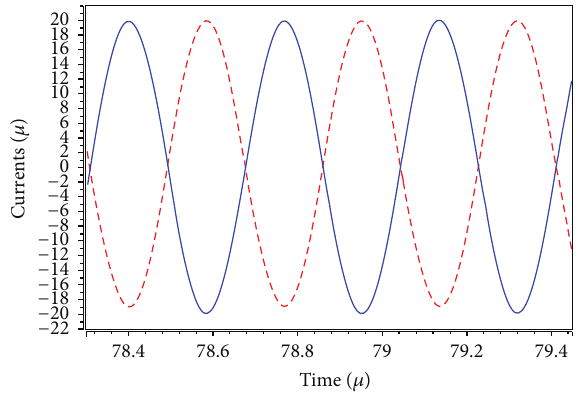
Figure 7: Postlayout simulation responses in Case 2 (highpass response: red; bandpass response: green; lowpass response: pink; bandreject response: blue; allpass response: purple; and 𝑉 𝐶1 = 𝑉 𝐶2 = = 1 V). 𝑉 𝐶3